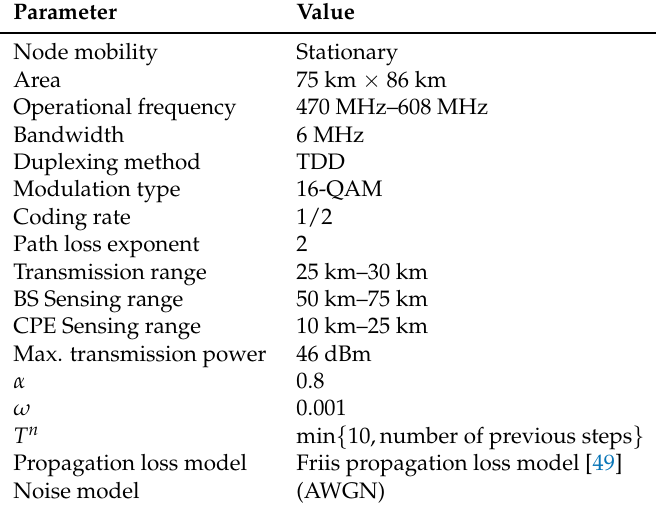
Table 2. ns-3 implementation